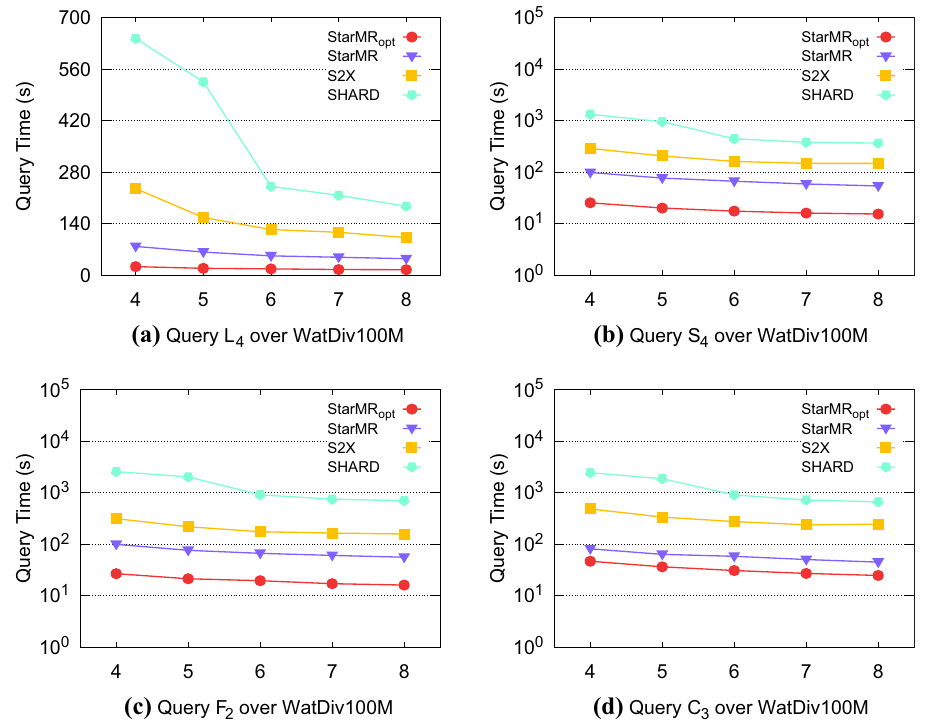
Fig. 7 Scalability on cluster sites